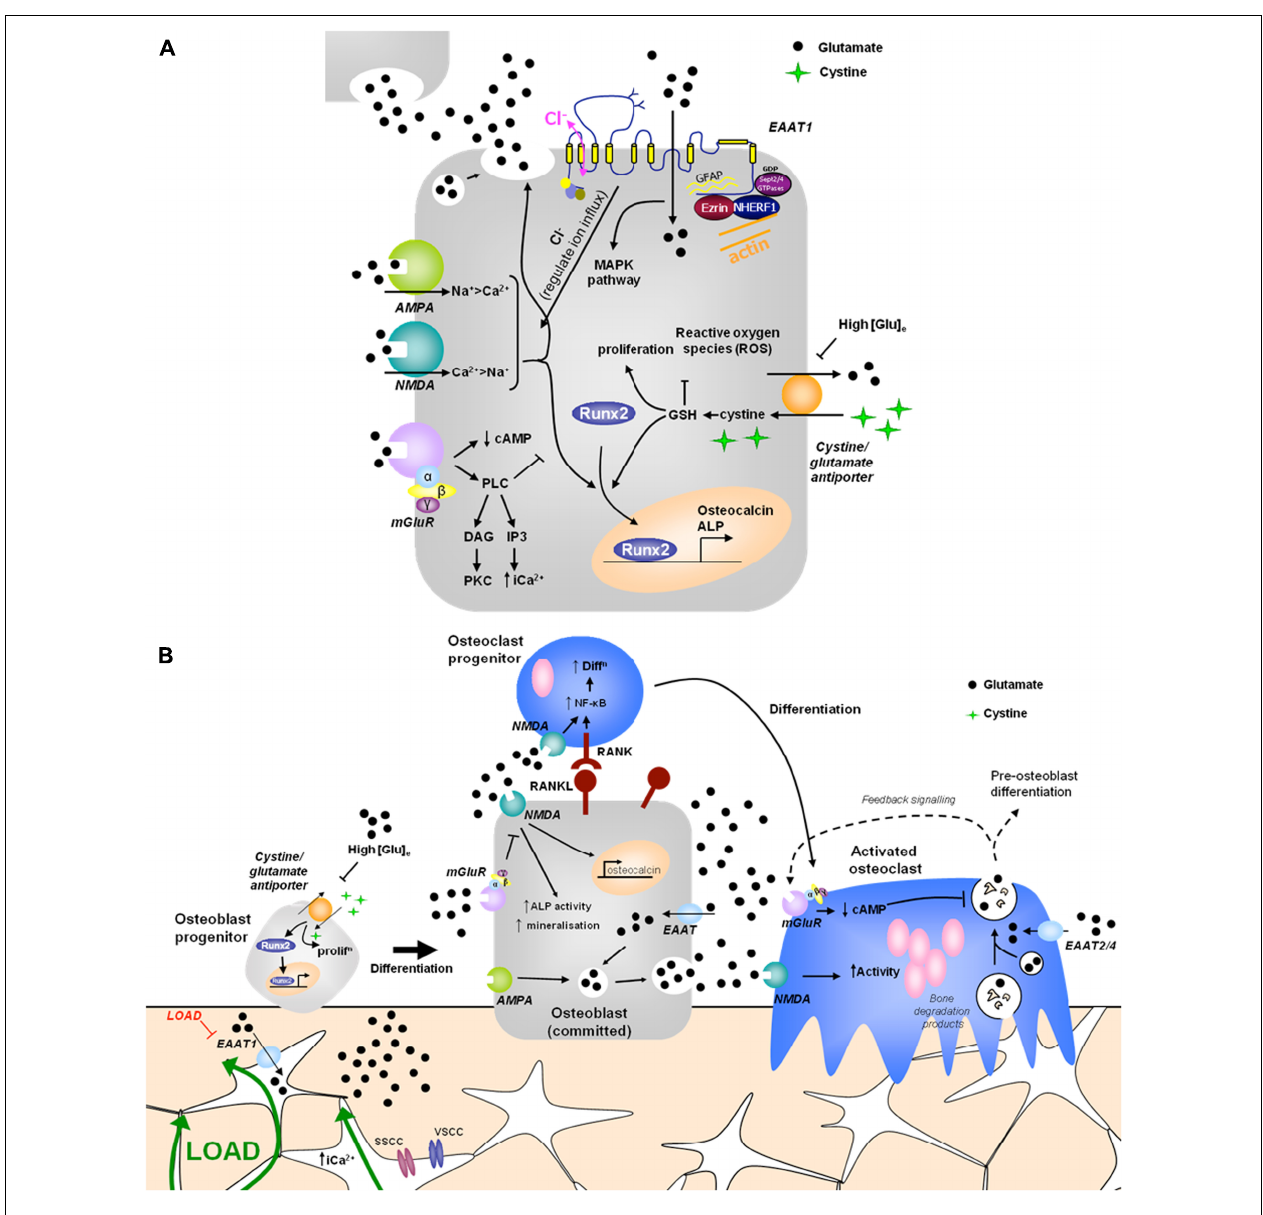
FIGURE 1 | Hypothetical model of glutamate signaling in (A) osteoblasts and (B) bone. (A) Osteoblasts release glutamate to activate glutamate receptors in an autocrine and paracrine manner and express functional ionotropic and metabotropic glutamate receptors. iGluR activation leads to glutamate release and increased Runx2 activity, regulating osteocalcin expression, ALP activity and mineralization (Hinoi etal., 2002c, 2003; Ho etal., 2005). mGluR activation inhibits NMDA receptor signals in osteoblasts via PLC activated pathways (Gu and Publicover, 2000). High extracellular [glutamate] inhibits the cystine/glutamate antiporter, suppressing proliferation and reducing Runx2 activity due to depletion of GSH (Uno etal., 2007; Takarada-Iemata etal., 2010). EAATs transport glutamate into osteoblasts, modulating localized receptor responses, but also activating a chloride flux, which may function as a voltage clamp, act directly as a receptor, or modulate GluR activation by regulating ion influx (Danbolt, 2001; Huggett etal., 2002). Various proteins interact with the intracellular domains of EAAT1 and glutamate transport through EAATs activates MAPK (Abe and Saito, 2001). (B) Opening of stretch- and voltage-sensitive calcium channels (SSCC,VSCC) in osteocytes in response to mechanical load increases